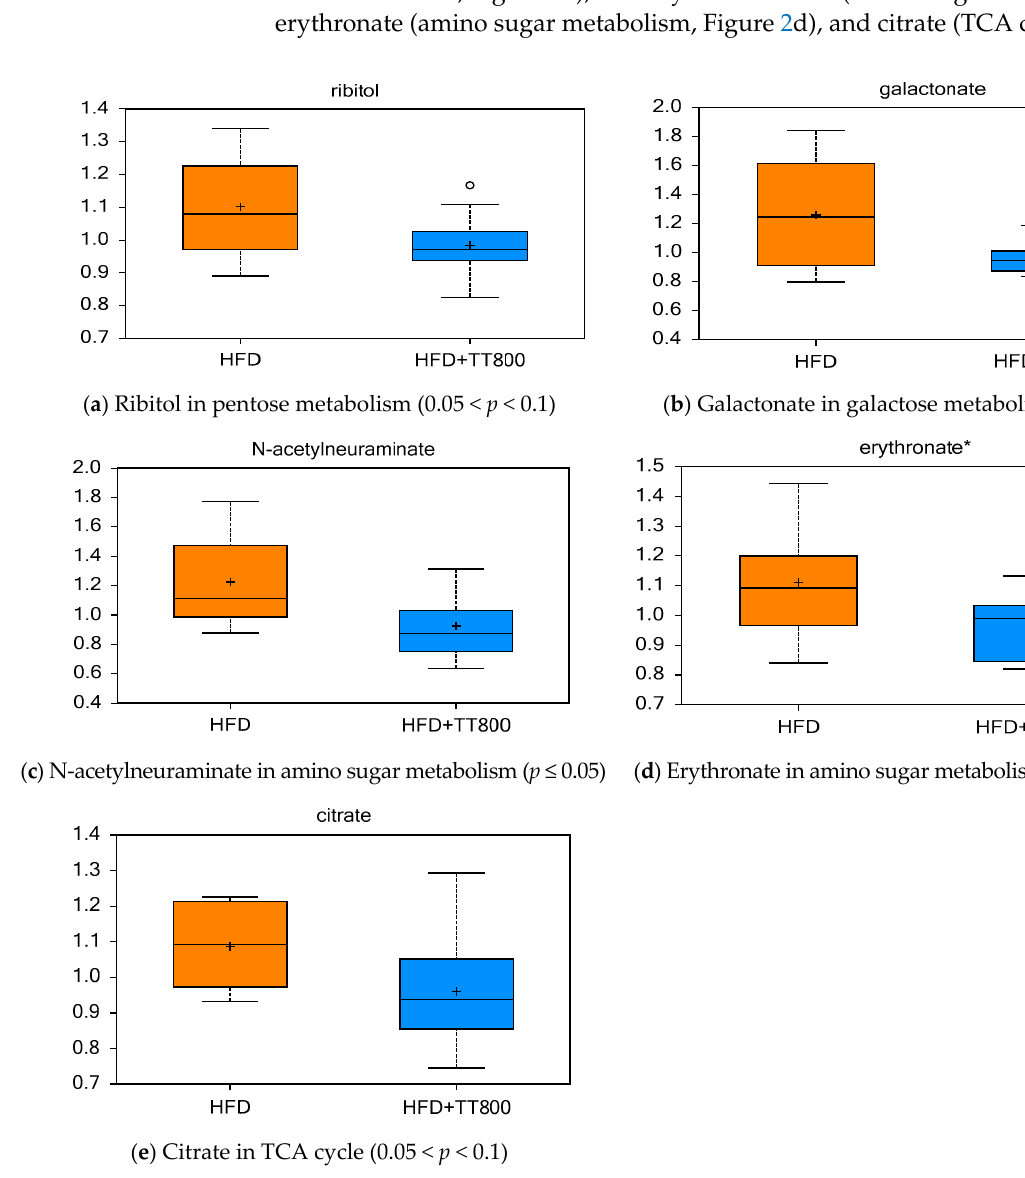
Figure 2. Effect of TT supplementation on carbohydrate metabolism. Importance of compounds relative to flux through carbohydrate metabolism and biosynthetic pathways in mice given TT. A lower level of citrate ( e ) in mice given TT might indicate a higher flux of TCA to support better energy production and use, and lower macronutrient carbon to support fat deposition when a HFD is fed. Generally, figures ( a – d ) suggest lower formation of these anabolic pathway intermediates. Each dietary group was comprised of n = 10